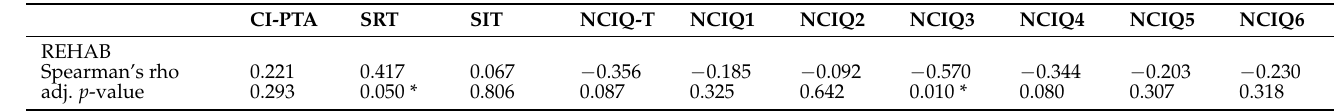
Table 6. Partial correlation matrix of the rehab factor with the clinical characteristics, audiological outcome, and